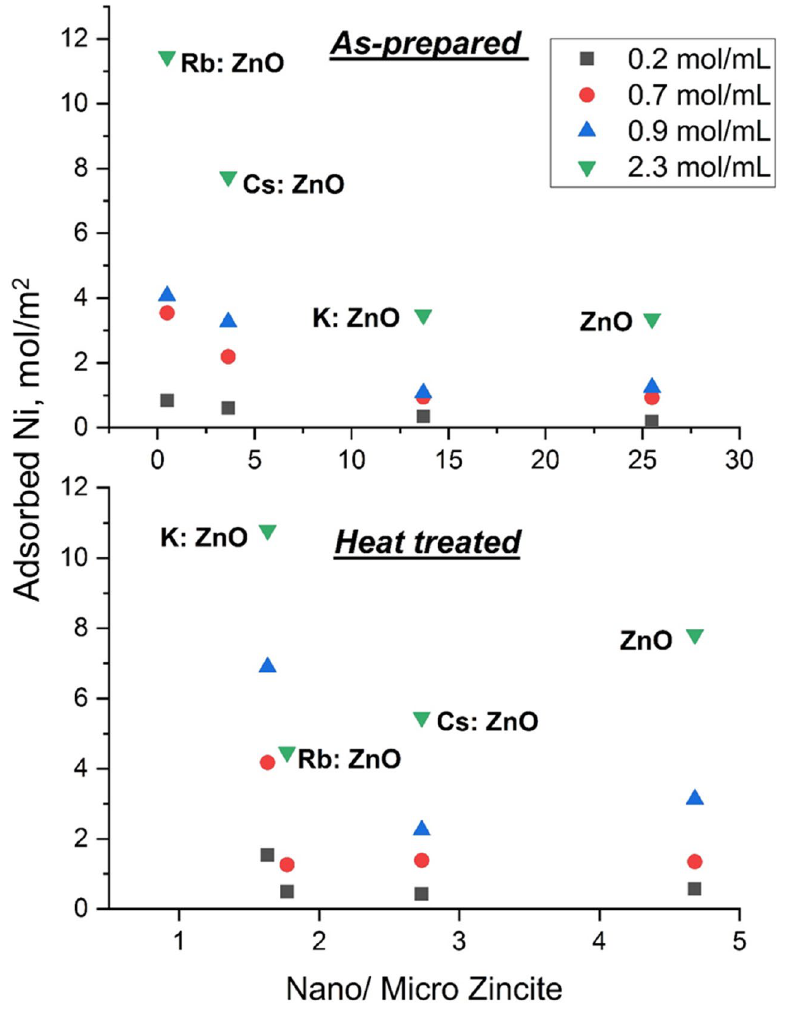
Figure 6. Adsorption of Ni 2+ ions as function of nano-zincite /micro-zincite ratio of the